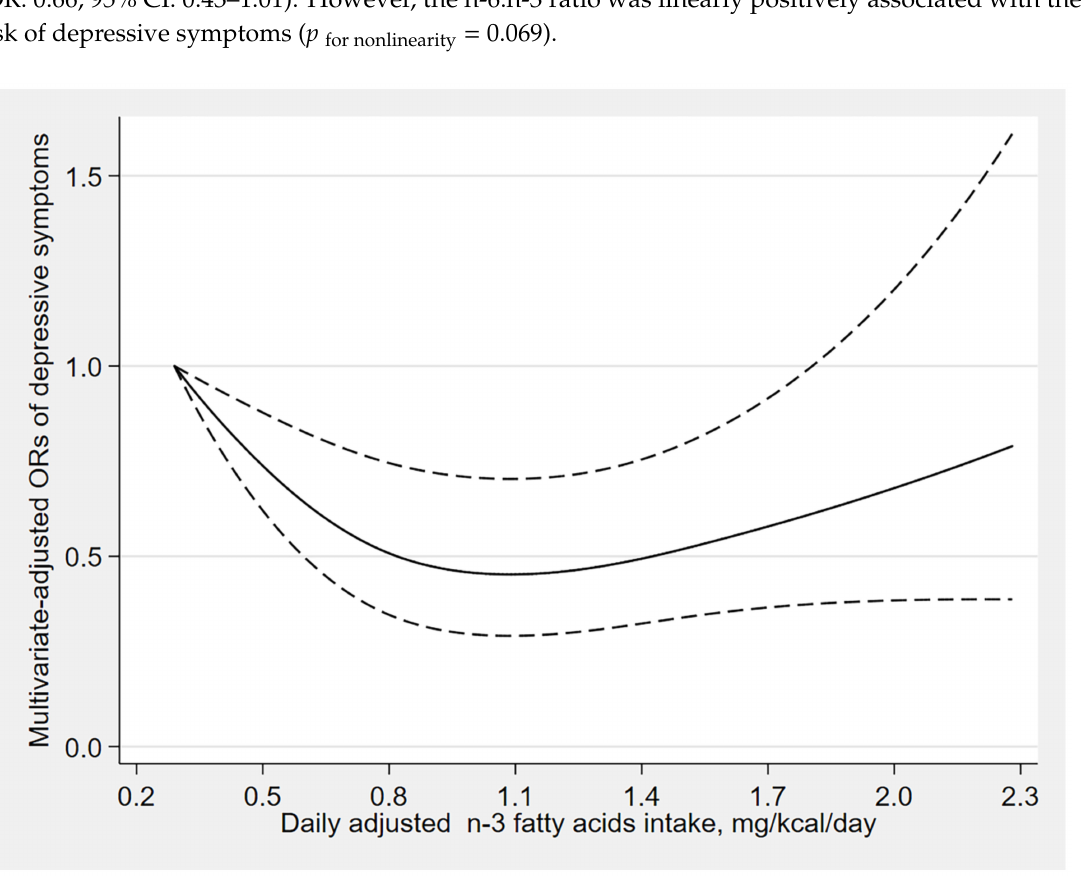
Figure2. Dose–responserelationshipbetweenn-3fattyacidsintakeandtheriskofdepressivesymptoms. The solid line represents the OR values and dashed lines represent the 95% confidence